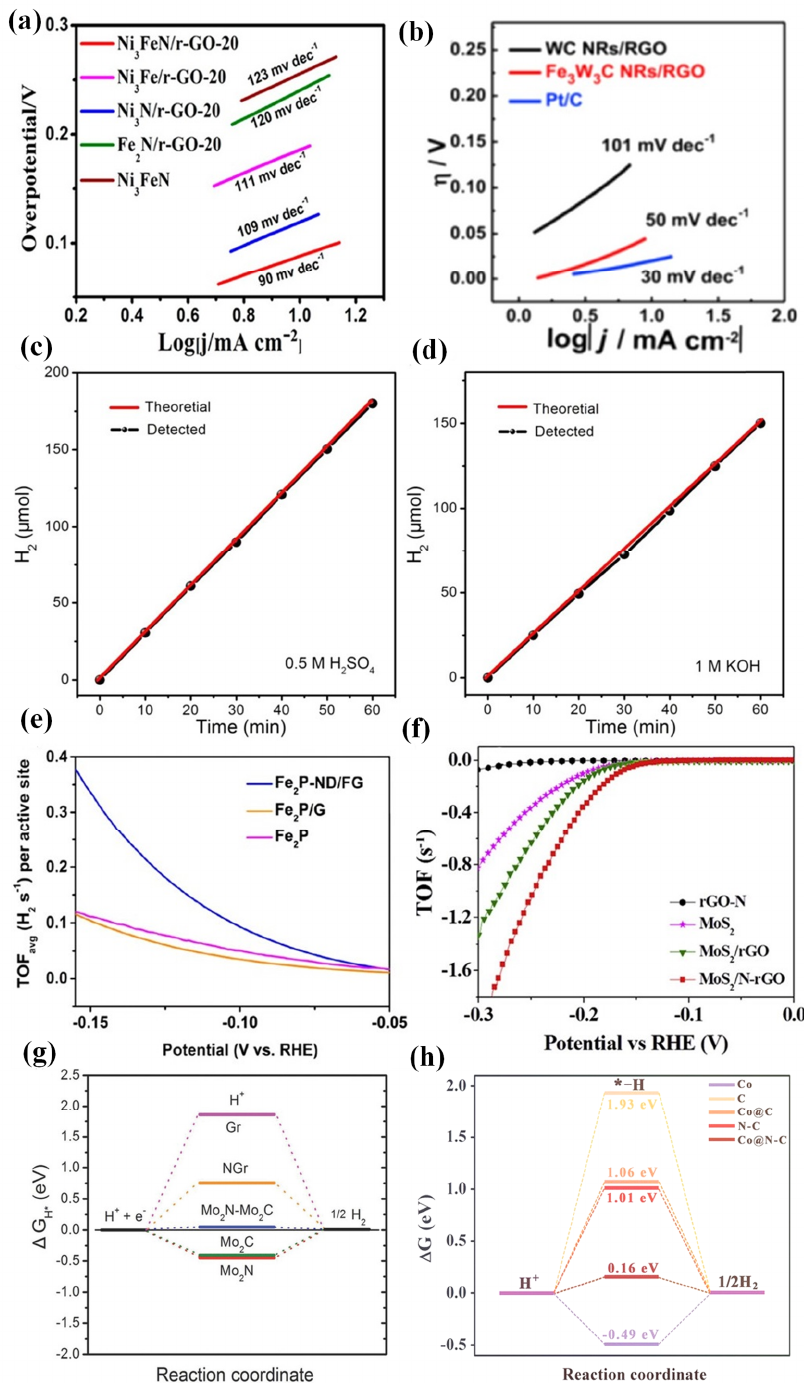
Figure 2. Tafel plots of ( a ) Ni 3 FeN/r-GO-20, Ni 3 Fe/r-GO-20, Ni 3 N/r-GO-20, Fe 2 N/r-GO-20, and Ni 3 FeN [25]; ( b ) Pt/C, WC NRs/rGO, Fe 3 W 3 C NRs/rGO, and Pt/C [26]; The theoretical and experimental amount of H 2 vs. t (min) for Mo 2 N-Mo 2 C/H-rGr in ( c ) 0.5 M H 2 SO 4 solution and ( d ) 1.0 M KOH solution for 60 min at − 200 mV [28]; ( e ) TOF values of the as-synthesized Fe 2 P, Fe 2 P/Gr, and Fe 2 P-ND/FGr at different overpotentials [29]; ( f ) turnover frequency (TOF) of MoS 2 /N-rGO 0.5 , MoS 2 /rGO, MoS 2 , and rGO-N at a scan rat of 50 mV s − 1 in a 0.5M H 2 SO 4 solution [30]. ( g ) The ∆ G H * value for HER based for various electrocatalysts [28]. ( h ) The calculated value of C, Co@C, N-C & Co@N-C, respectively